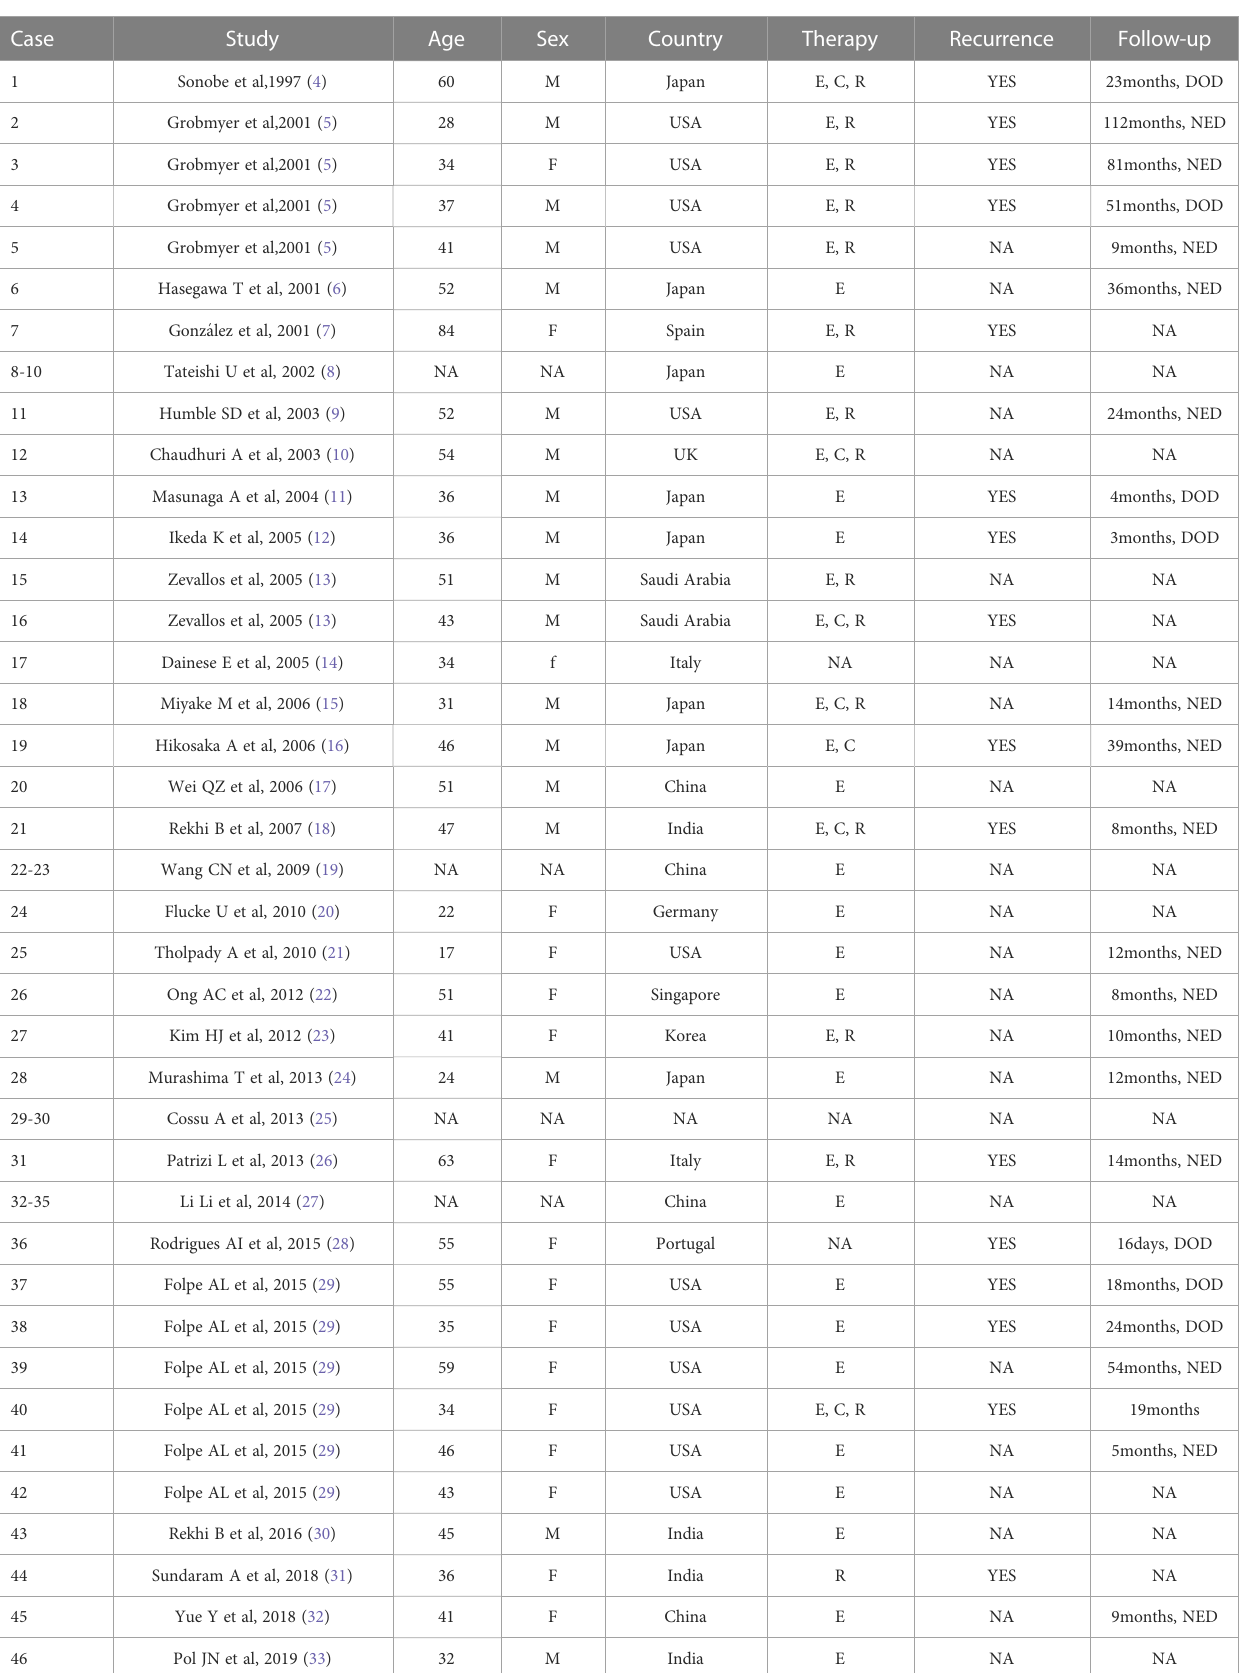
TABLE 1 Reported cases of ES of the